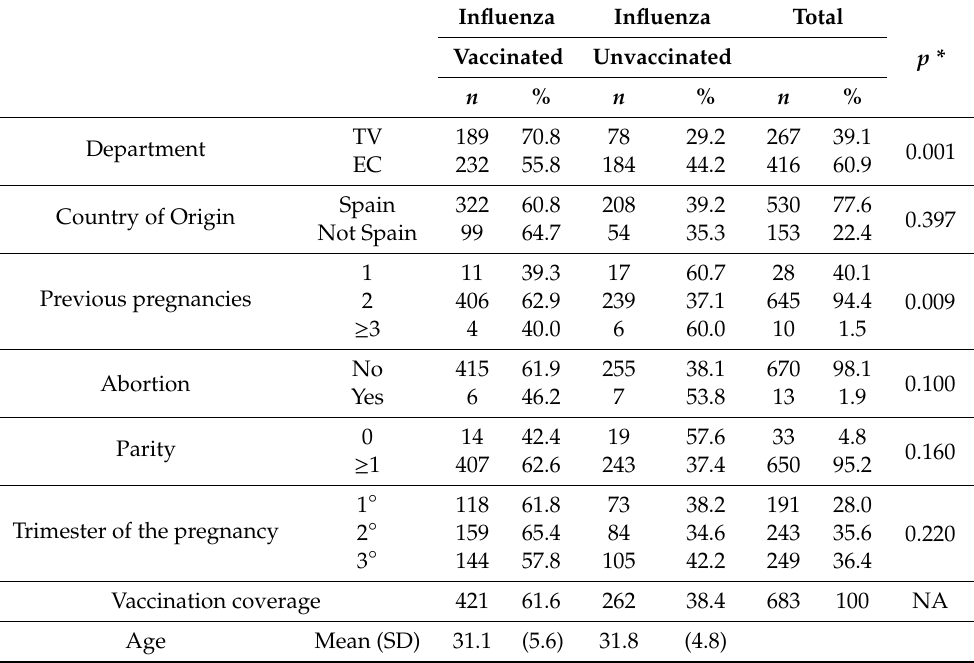
Table 1. Frequencies n , percentages % distribution of the women